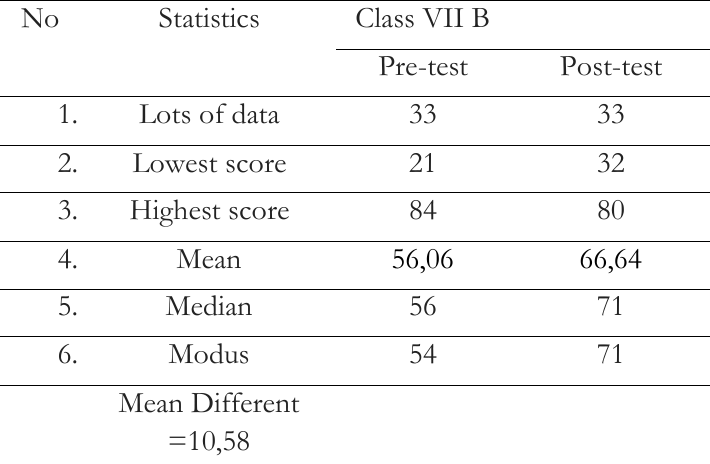
TABLE 2 Respondents' Assessment of Pre-test and Post-test Control